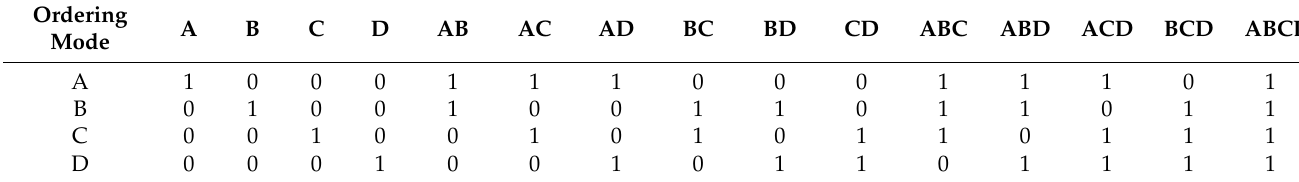
Table 5. Matrix of product ordering modes.